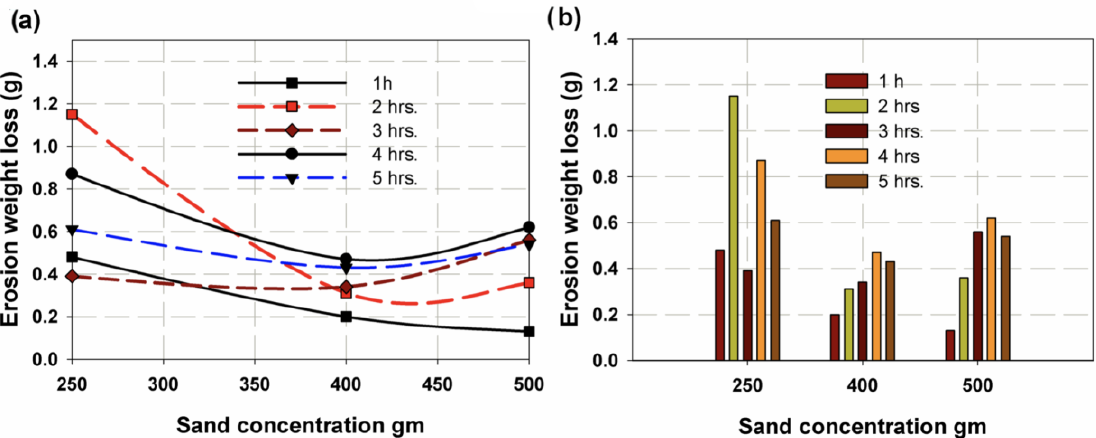
Figure 7. Erosion weight loss variation with time of impact ( a ) total trend, ( b ) maximum value . Figure 6. Corrosion rate variation with abrasive sand amount: ( a ) total trend, ( b ) maximum value.